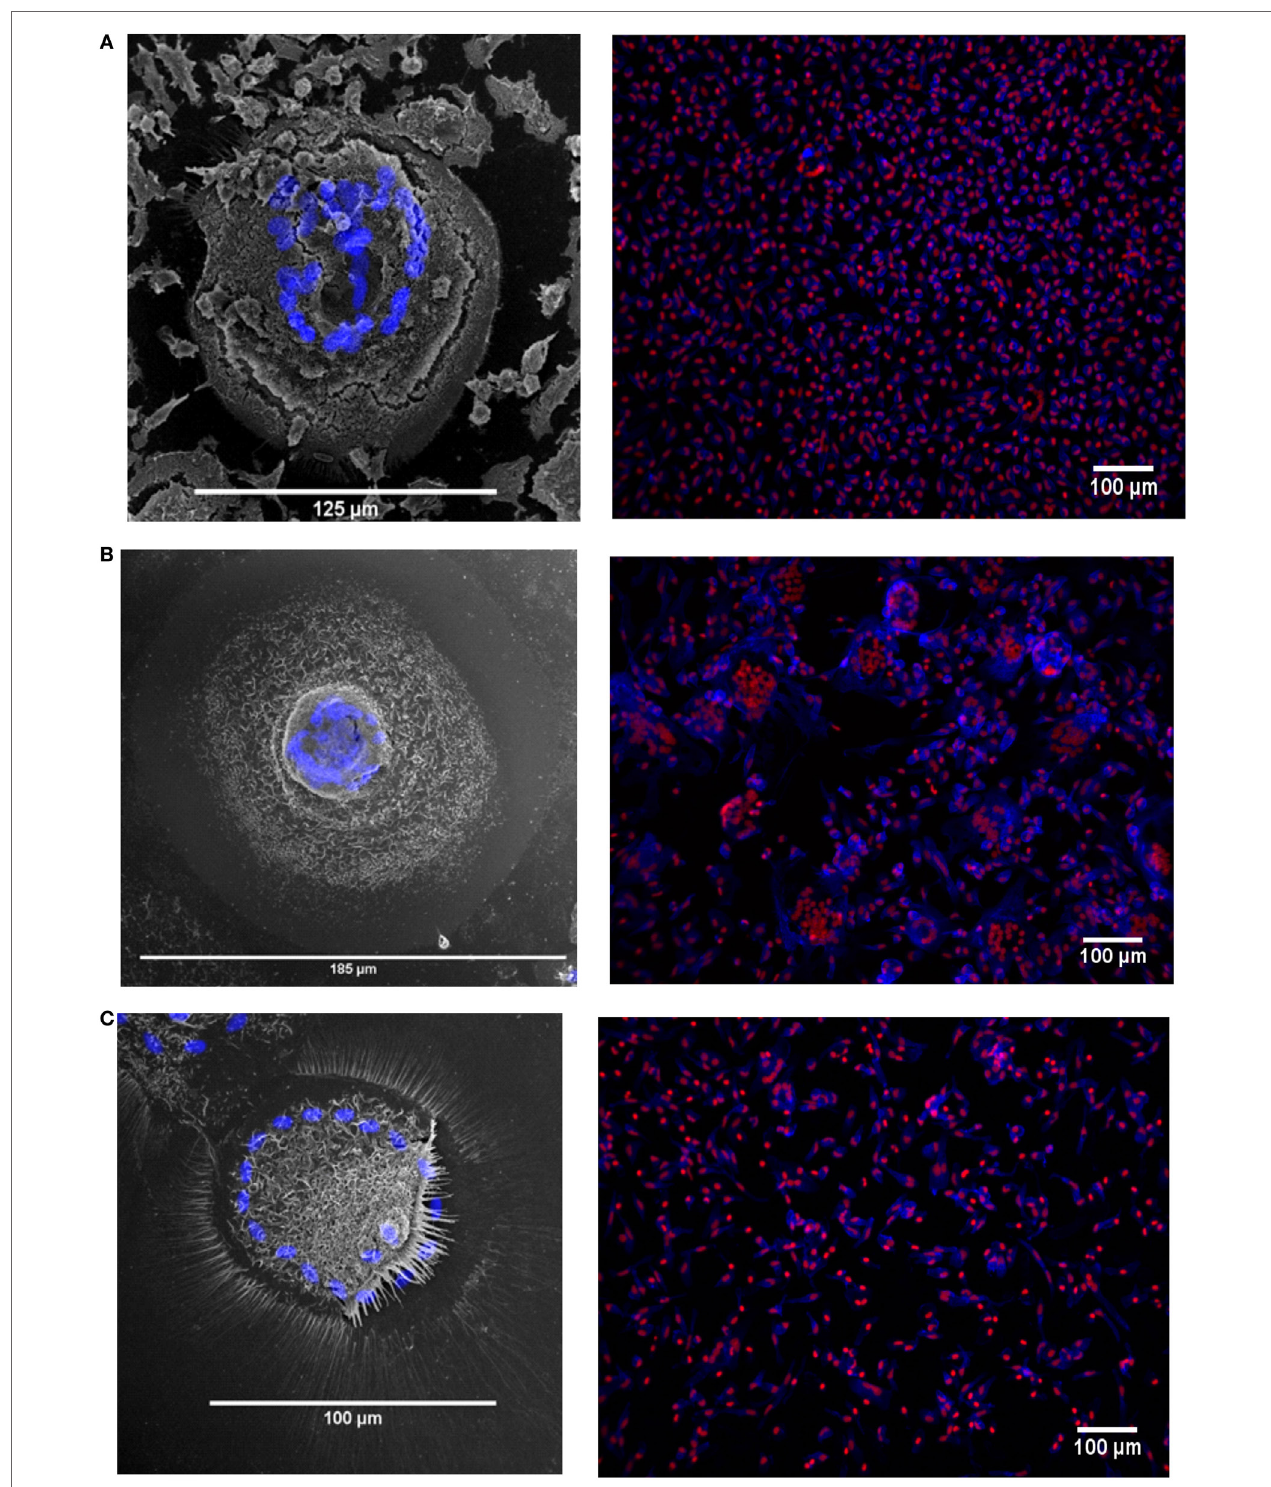
FigUre 2 | Fusion in different monocyte subsets imaged by tandem fluorescent scanning electron microscopy (SEM) and wide field fluorescence microscopy. (a–c) left panels. monocyte­derived giant cell (MGC) were generated by 72­h concanavalin A (ConA) treatment of FACS­sorted monocyte subsets, stained with Hoechst and then raster­scanned so that the MGC imaged in SEM could be located and the nuclear channel overlaid onto the image. Nuclei shown in blue. (a–c) right panels. Three representative montages containing images taken of each of the monocyte subsets from one donor after 72 h ConA treatment. Blue = F­actin, Red = nuclei. (a) classical, (B) intermediate, (c) non­classical subset­derived